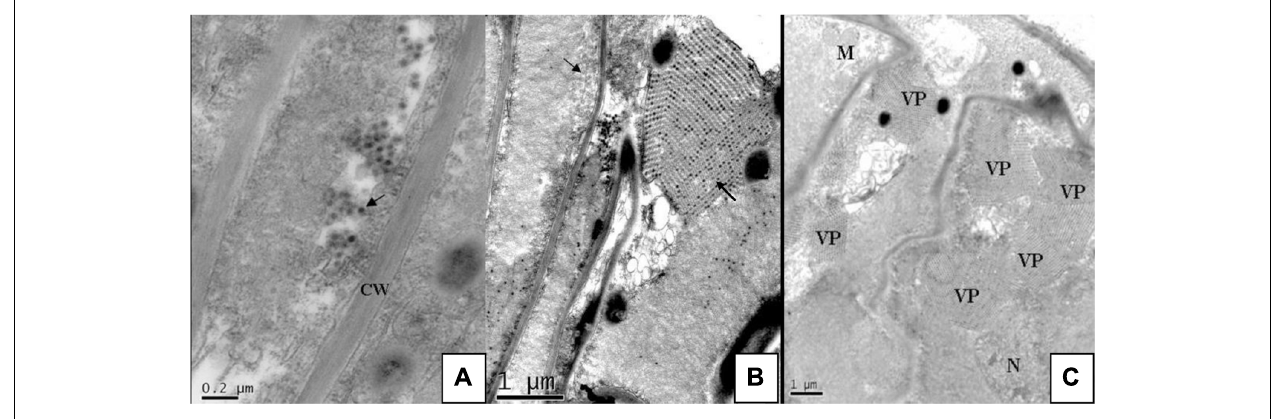
tubule (arrow) and numerous virus particles aggregated into crystalline array in the viroplasms (arrow). (C) Viroplasms full of virus scattered in the cytoplasm. CW, cell wall; N, nucleus;VP, viroplasm; M,